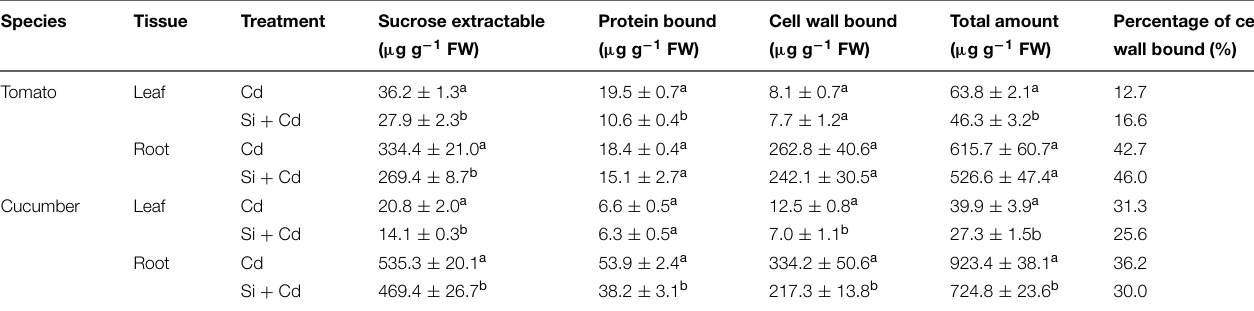
TABLE 3 | Cadmium concentrations in different fractions extracted from the roots and leaves in tomato and cucumber plants.